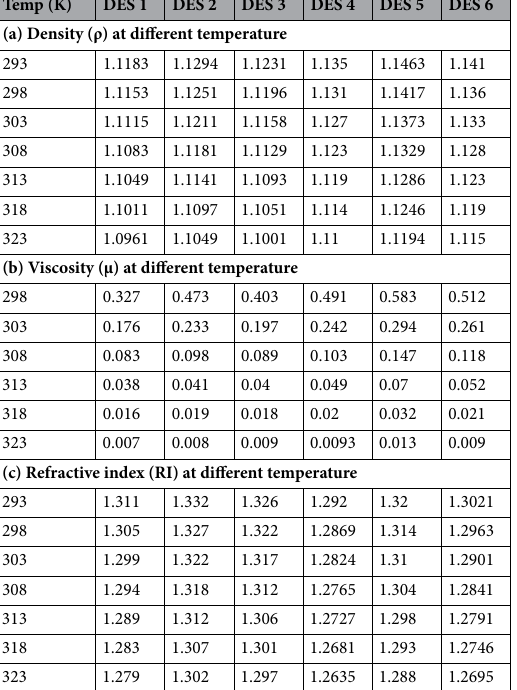
Table 4. Measurement of density, viscosity and refractive index at various temperature. *(a) Standard uncertainty is u (T) = 0.1 K (0.63 confidence level) and expanded uncertainty of density is U (ρ) = 0.02 gcm −3 . *(b) Standard uncertainty is u (T) = 0.1 K (0.63 confidence level) and expanded uncertainty of density is U (µ) = 0.2 kgm −1 s −1 . *(c) Standard uncertainty is u (T) = 0.1 K (0.63 confidence level) and expanded uncertainty of density is U (RI) =